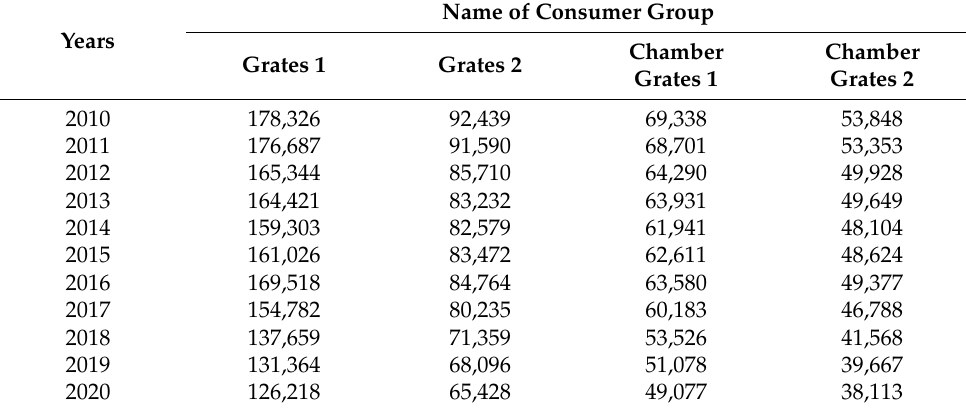
Table A3. The historical volumes of coal demand from the domestic consumers in the years 2010–2020, (Mg).